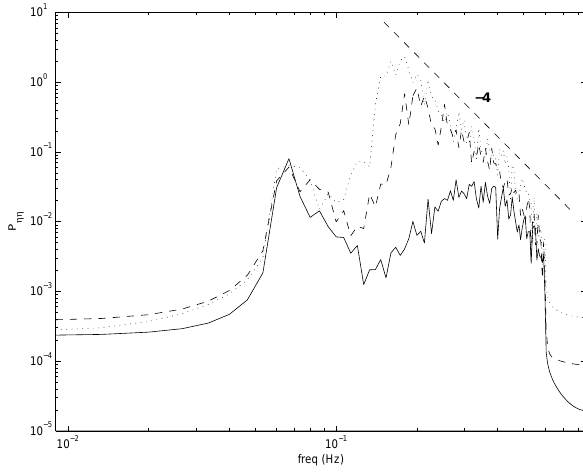
Fig. 1. Simultaneous long-term wind and wave growth processes; arrows indicate the centres of the three episodes for Figs. 2 and 3.